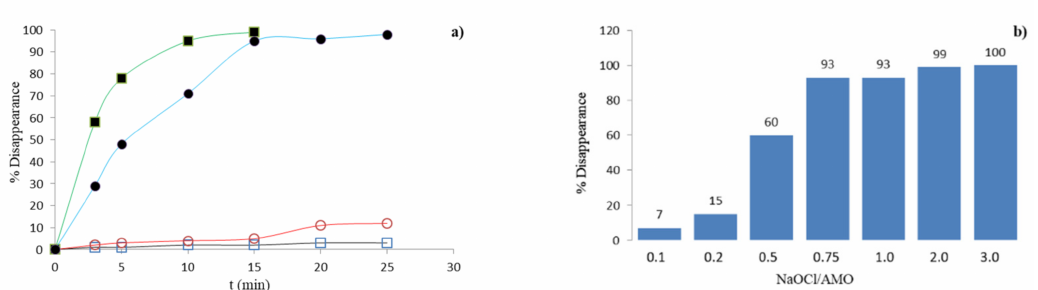
Figure 2. ( a ) Time-conversion plot for the reaction of AMO with one equivalent NaOCl at pH = 9.0. ■ : NaOCl consumption in the presence of AMO (green); ● : AMO consumption by reaction with NaOCl (blue); □ : Disappearance of NaOCl in the absence of AMO (red); ○ : Disappearance of AMO in the absence of NaOCl (black); ( b ) AMO disappearance by NaOCl at pH basic no-buffered after a 5 min reaction.